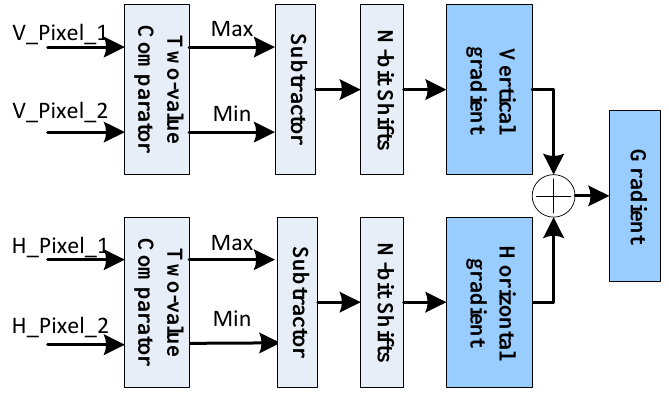
Figure 7. Parallel gradient computation